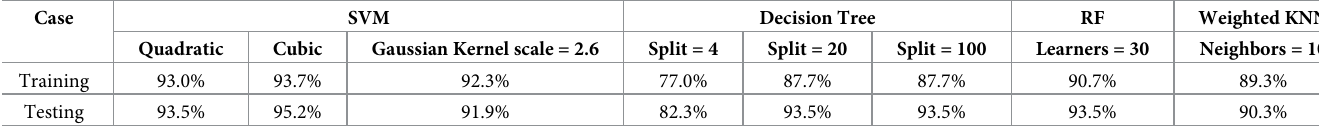
Table 4. Accuracy of different classification